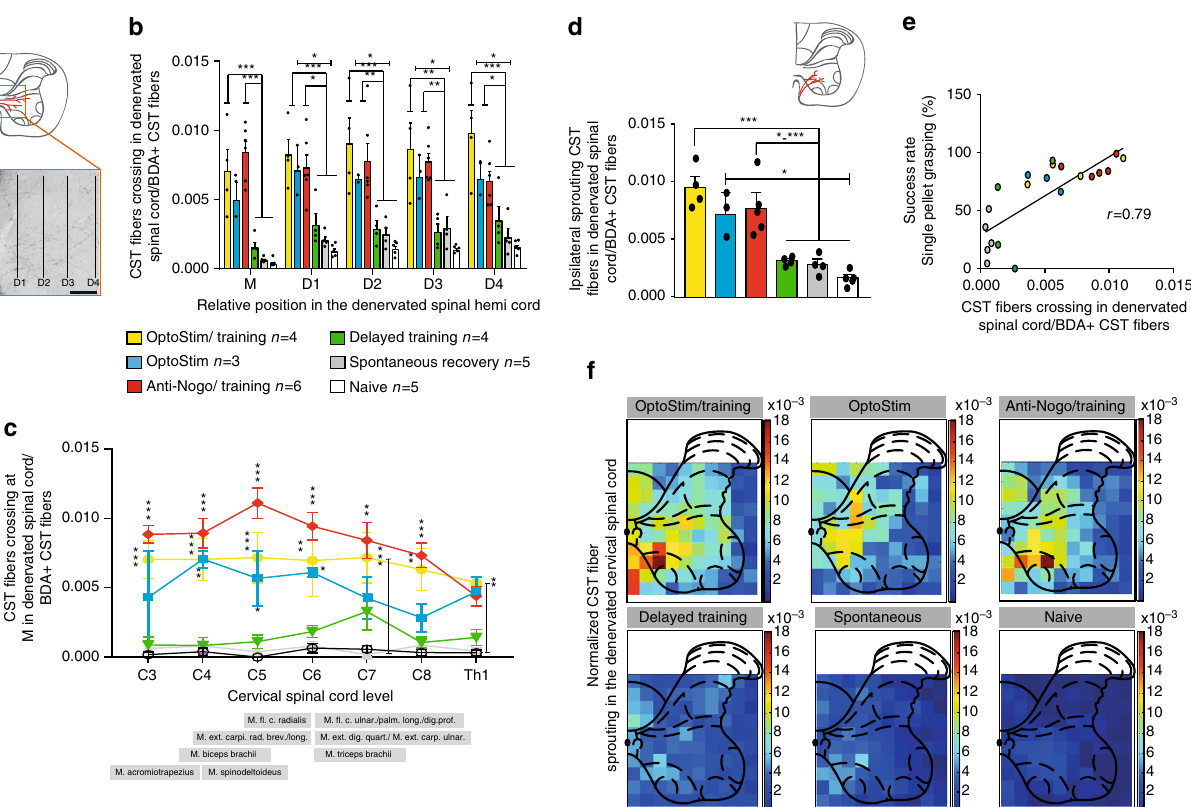
Fig. 4 Corticospinal fi ber sprouting from intact to denervated spinal hemi-cord is enhanced by early cortical stimulation. a Corticospinal tract fi bers from the intact, contralesional motor cortex cross the spinal cord midline (M) and grow into the corticospinally denervated gray matter for various distances (D1 – 4, scale bar = 200 µ m). b Values were signi fi cantly higher in the stimulation groups and the anti-Nogo-A group. c Segment-speci fi c analysis of midline crossing fi bers showed that the two stimulation groups and the “ Anti-Nogo/Training ” group had signi fi cantly more midline crossing fi bers in the more rostral cervical spinal cord where motoneuron pools controlling proximal forelimb muscles are located, whereas fi ber sprouting in the more caudal cervical spinal cord where motoneuron pools for the distal muscles are located was less pronounced compared to the “ Spontaneous recovery ” and “ Delayed training ” groups as well as in naive animals. d Sprouting of pre-existing ipsilateral CST fi bers in the gray matter of the cervical enlargement after stroke was also most pronounced in the “ Anti-Nogo/Training ” group as well as in the “ OptoStim/Training ” group. e There was a positive correlation between the amount of newly sprouting CST fi bers and the level of recovered grasping function of the impaired forelimb 4 – 5 weeks after stroke (r = 0.79, Spearman correlation, p < 0.0001). f Average false color-coded heat maps of CST fi ber sprouting densities in the denervated spinal cord at C4 level. In both stimulation groups and the “ Anti-Nogo/Training ” group, CST fi bers in particular sprouted in lamina 6/7 of the ventral horn. Asterisks represent statistical signi fi cance. Data are presented as means ± s.e.m.; statistical evaluation was carried out with two-way ANOVA repeated measure followed by Bonferroni post hoc, asterisks indicate signi fi cances: * p < 0.05, ** p < 0.01, and *** p < ANOVA with post hoc Bonferroni). Midline crossing was slightly less pronounced in the “ Stimulation ” alone group (Fig. 4c). Apart